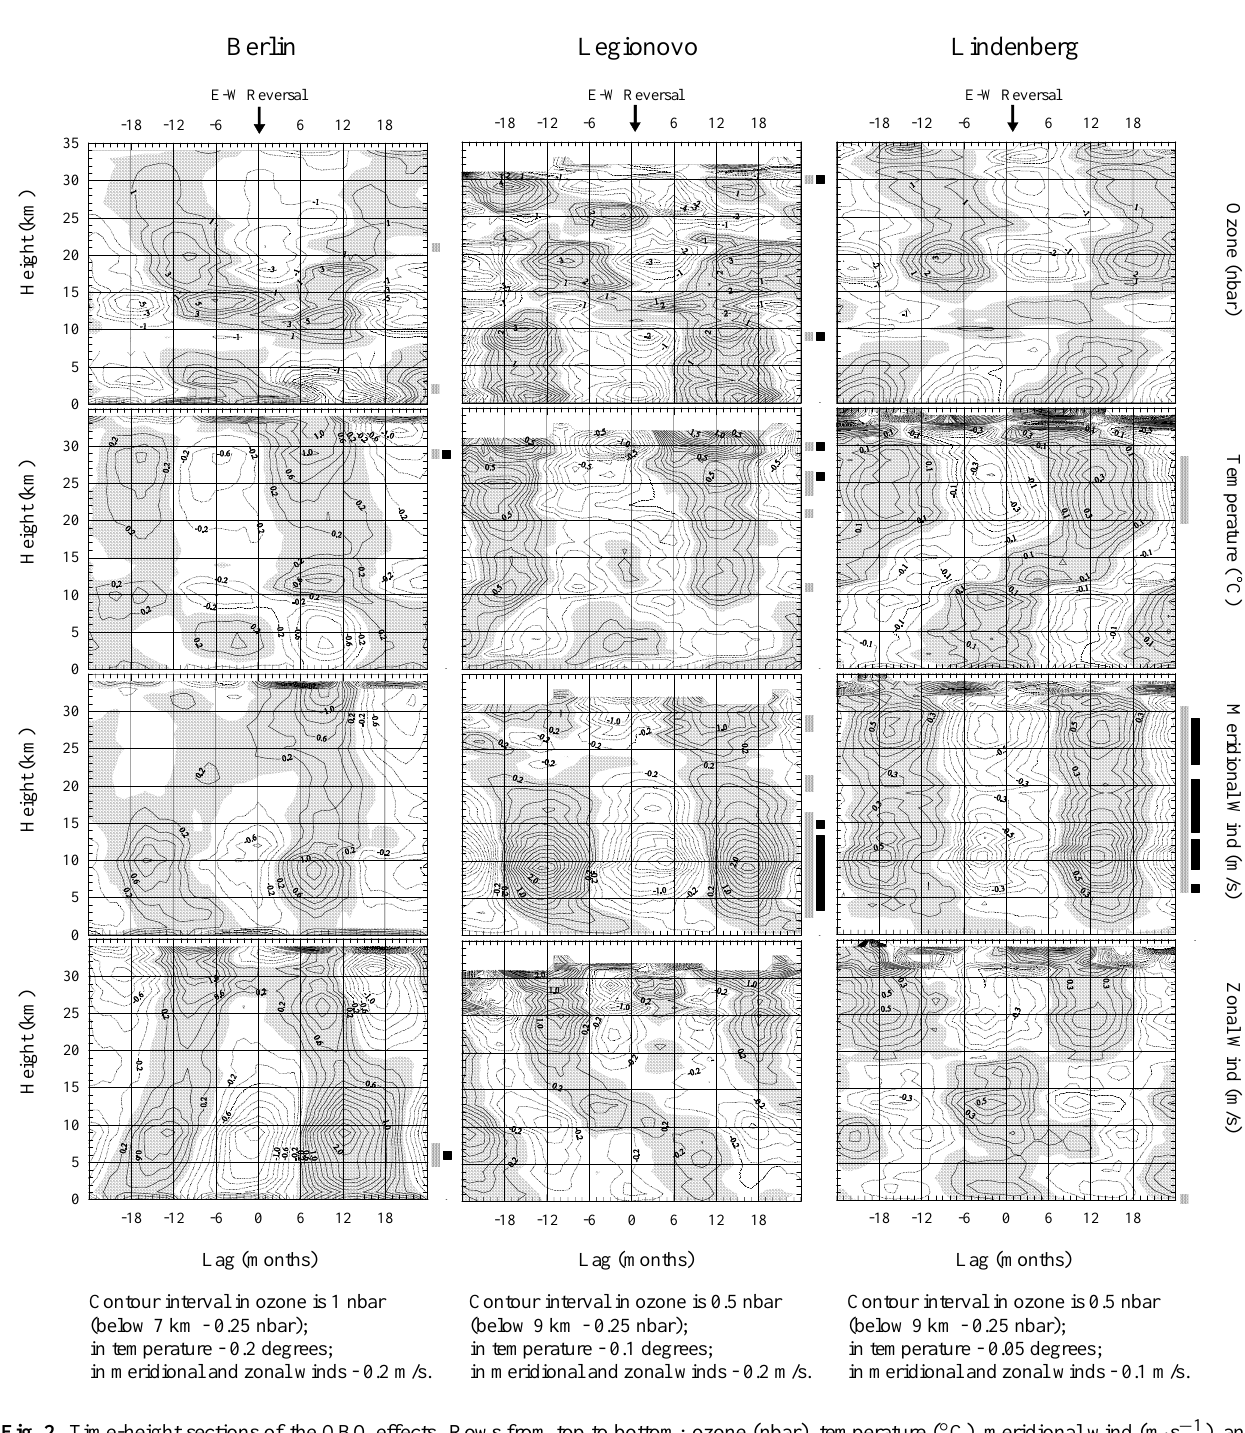
Contour interval in ozone is 1 nbar Contour interval in ozone is 0.5 nbar Contour interval in ozone is 0.5 nbar (below 7 km - 0.25 nbar); (below 9 km - 0.25 nbar); (below 9 km - 0.25 nbar); in temperature - 0.2 degrees; in temperature - 0.1 degrees; in temperature - 0.05 degrees; in meridional and zonal winds - 0.2 m/s. in meridional and zonal winds - 0.2 m/s. in meridional and zonal winds - 0.1 m/s. Fig. 2. Time-height sections of the QBO effects. Rows from top to bottom: ozone (nbar), temperature ( ◦ C), meridional wind (m · s − 1 ), and zonal wind (m · s − 1 ). Zero isolines are omitted. Positive deviations in ozone and temperature, as well as northward and eastward winds are shaded. Lag is time in months relative to a month of the E-W phase reversal of the 50-hPa equatorial zonal wind. Black (grey) squares on the right sides mark the heights where 95% (90%) confidence levels of positive and negative anomalies, forming quasi-biennial signal are not